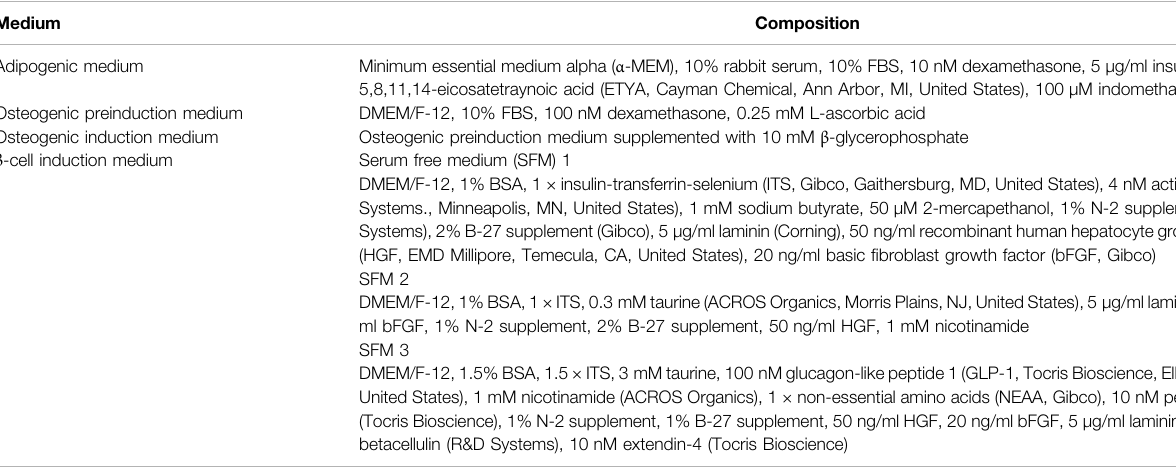
TABLE 1 | Differentiation media